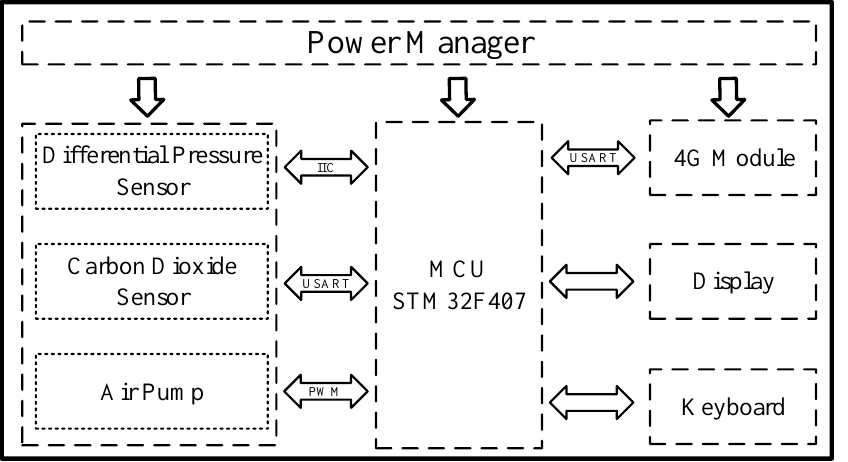
Figure 2. Embedded system of the handheld device. The microcontroller unit (MCU) communicates with the differential pressure sensor via Inter-Integrated Circuit (IIC) protocol, with the carbon dioxide sensor via Universal Synchronous/Asynchronous Receiver/Transmitter (USART) protocol, and the air pump control via pulse-width modulation (PWM) wave.